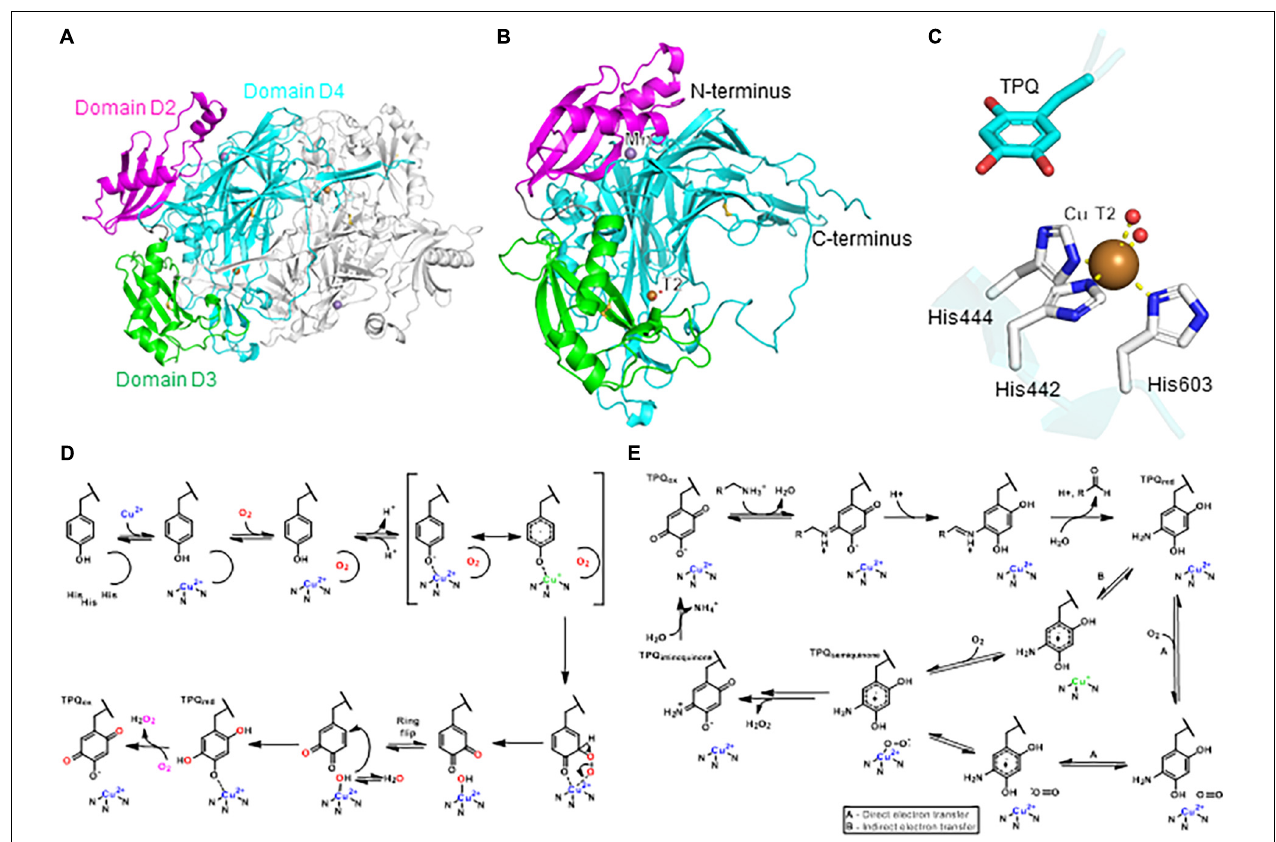
FIGURE 5 | Structure and mechanism of a plant copper-dependent amine oxidase. (A) Homodimer protein structure of pea copper-dependent amine oxidase (PDB ID: 1KSI) (Kumar et al., 1996). (B) Monomer structure of pea CuAO. (C) T2 copper center with copper-binding residues and TPQ cofactor. Copper coordination is highlighted by yellow dashed lines. (D) Proposed mechanism of TPQ biogenesis. Adapted with permission from Dubois and Klinman (2005; Copyright 2005 Elsevier). (E) Proposed catalytic mechanism of CuAO. Adapted with permission from Mills et al. (2019; Copyright 2019 Springer Nature). In panels (A,B) , the three domains D2, D3, and D4 are highlighted in magenta, green, and cyan, respectively. In panels (A–C) , copper atoms are shown as brown spheres, manganese atoms as purple spheres, water molecules as red